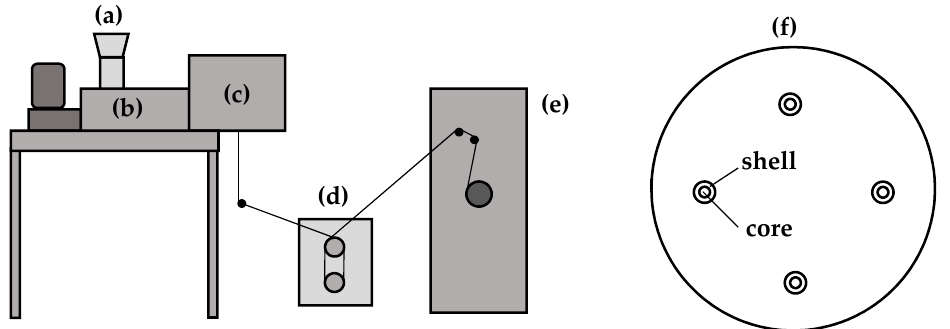
Figure 1. Laboratory-scale melt spinning setup and sketch of the 4-hole spin plate: ( a ) hopper; ( b ) extruder; ( c ) spin head; ( d ) godet duo; ( e ) winder; ( f ) 4-hole core–shell spin plate with supporting air in the core.